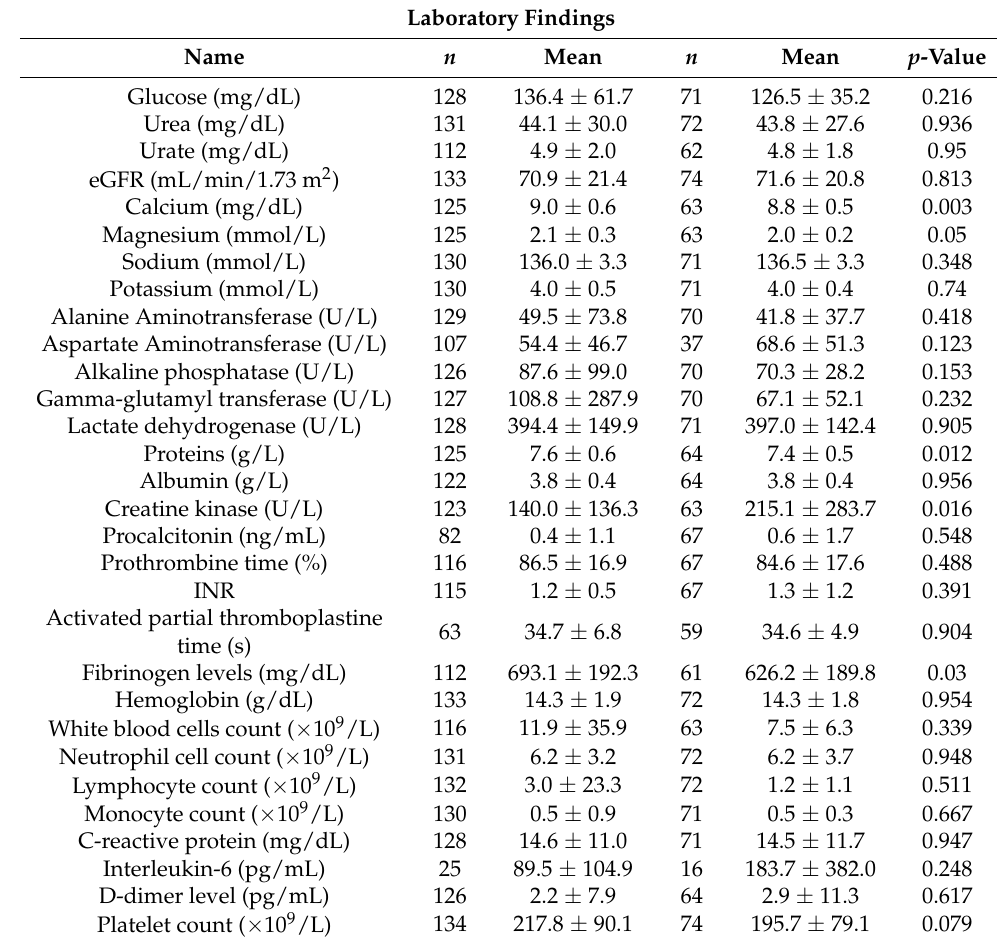
Table 2. Admission laboratory findings of patients from internal validation cohort by